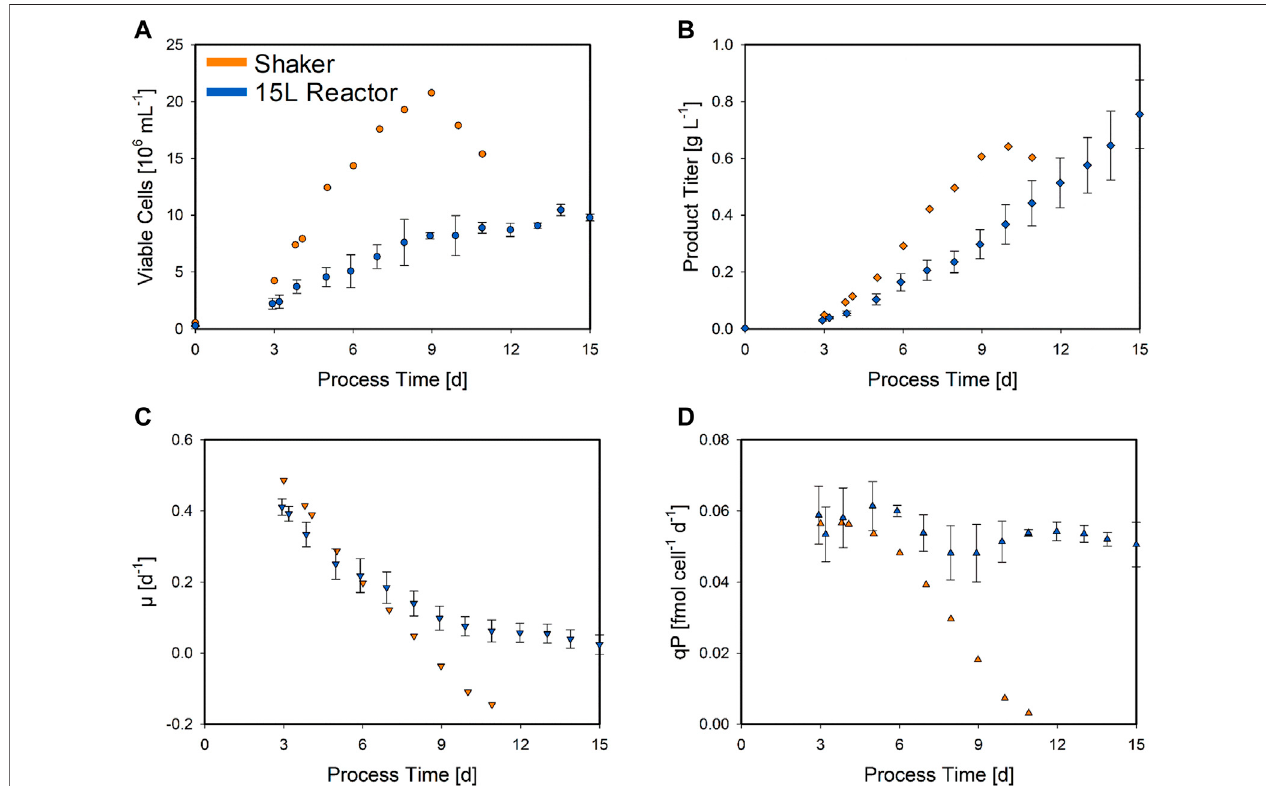
FIGURE 2 | Biomass and product-related trends for the center point CPP combination, performed in the bolus-fed shaker and bioreactor at which a continuous feed was applied. The means of the analytical shaker (orange symbols) and bioreactor (blue symbols) measurements are compared. The average values for the VCC (circles) (A) , product titer (squares) (B) , speci fi c growth rate (downward triangles) (C) , and speci fi c product formation rate (triangles) (D) are shown. The standard deviation for the bioreactor experiments (N (cid:2) 3) is indicated by error